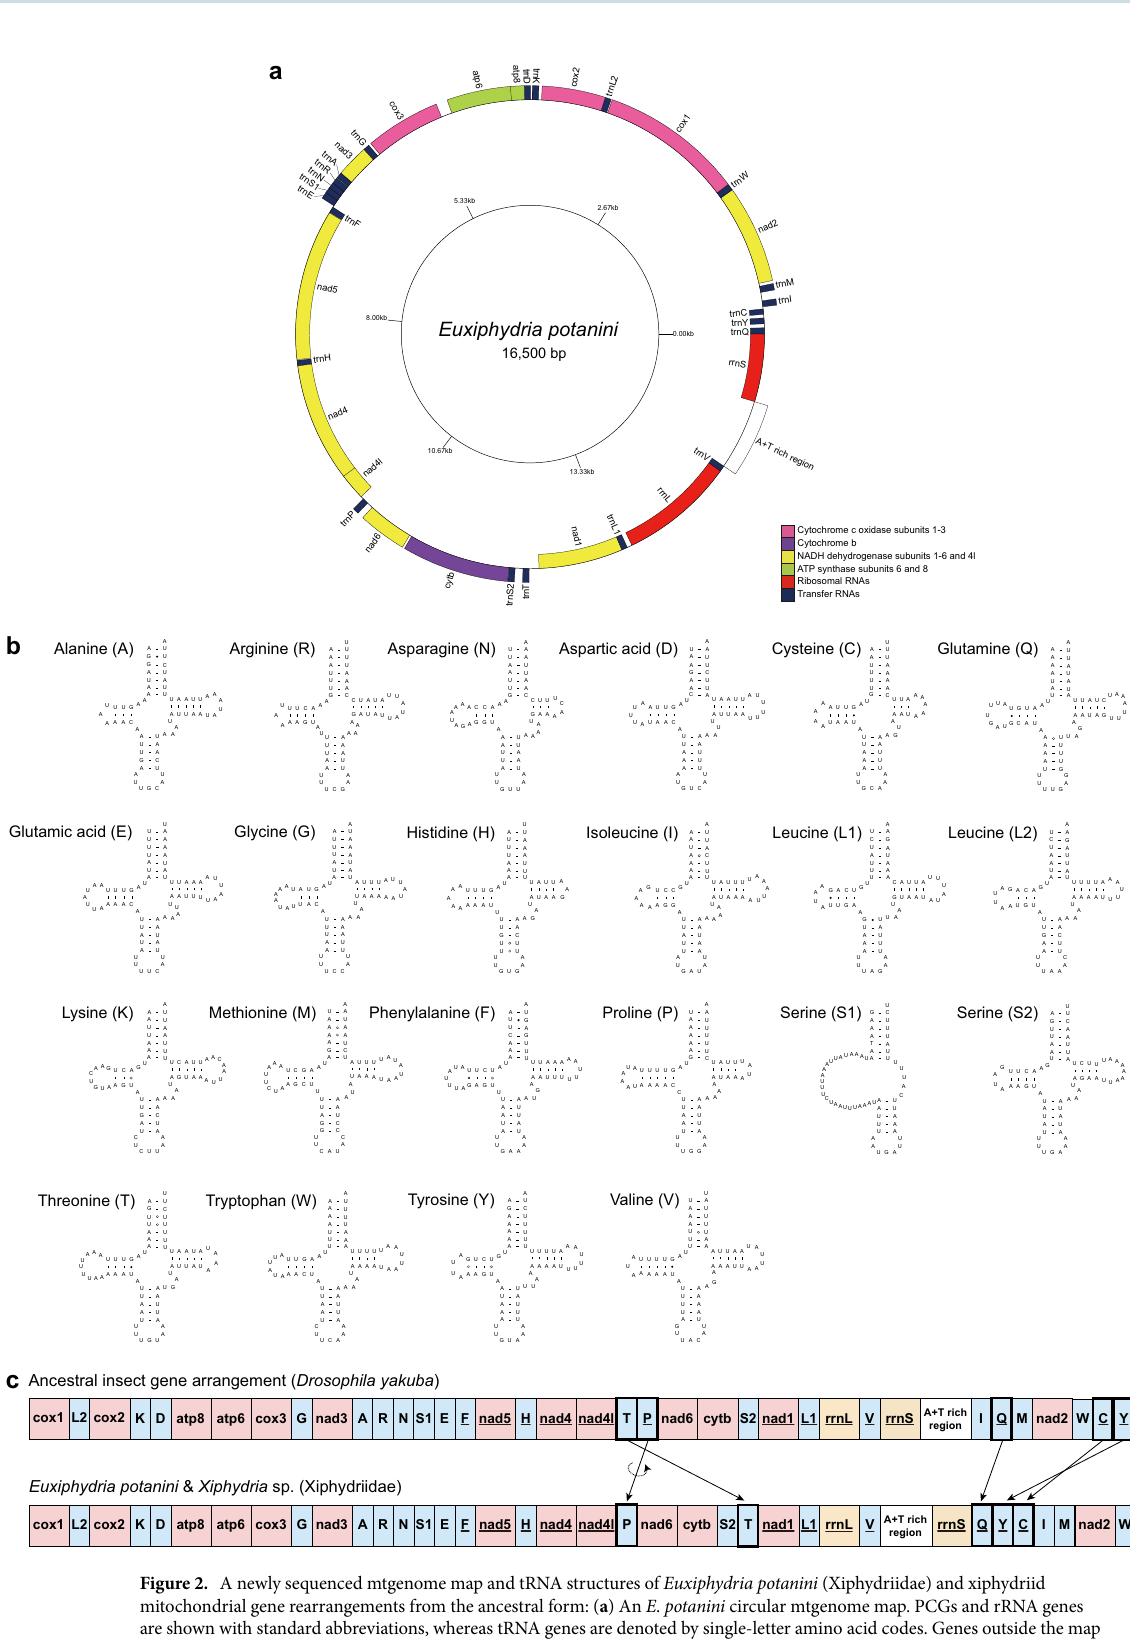
Figure 2. A newly sequenced mtgenome map and tRNA structures of Euxiphydria potanini (Xiphydriidae) and xiphydriid mitochondrial gene rearrangements from the ancestral form: ( a ) An E . potanini circular mtgenome map. PCGs and rRNA genes are shown with standard abbreviations, whereas tRNA genes are denoted by single-letter amino acid codes. Genes outside the map are coded on the H-strand and genes inside the map are coded on the L-strand; ( b ) Secondary structures of twenty-two E . potanini mitochondrial tRNAs predicted to be cloverleaf-shaped. Lines indicate A–U and G–C pairs, filled circles are G–U wobble binding, and empty circles represent no binding; ( c ) Comparison of mitochondrial gene arrangements of the two xiphydriid species with the ancestral insect form. The underlines represent genes encoded on the L-strand, arrows represent mitochondrial gene translocations, and the circle arrow indicates gene inversion. PCGs are indicated by red, rRNA genes by yellow, tRNA genes by blue, and an A + T rich region by white